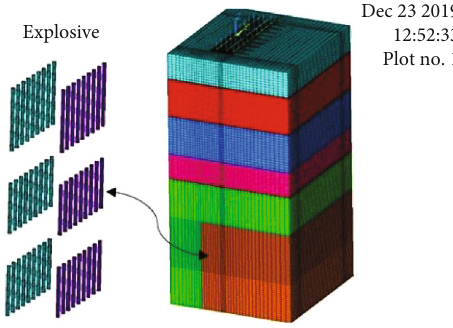
Figure 10: Bedrock blasting